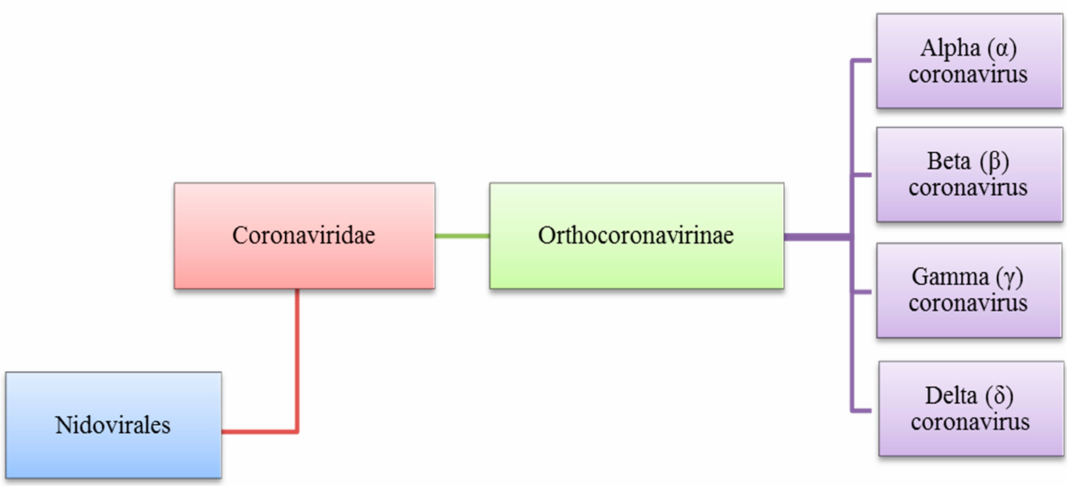
Figure 1. Diverse types of coronaviruses within Nidovirales, Coronaviridae family, Orthocoronavirinae subfamily and the respective genera, ( α ), ( β ), ( γ ) and ( δ